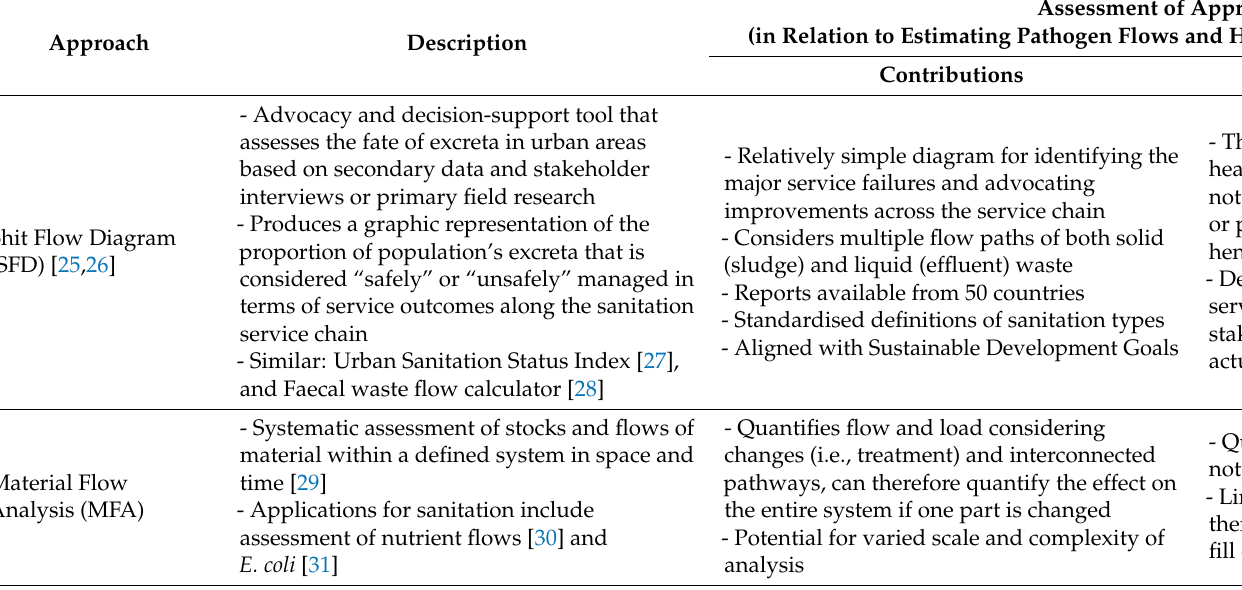
Table 1. Contributions and limitations of existing tools and approaches to estimate pathogen flows and health risks and inform decision